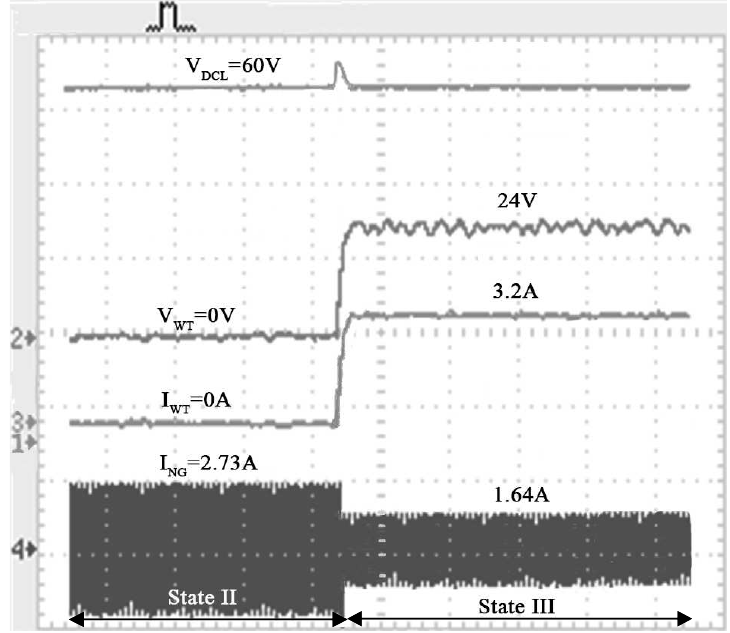
Figure 28. Experimental result for states II and III.